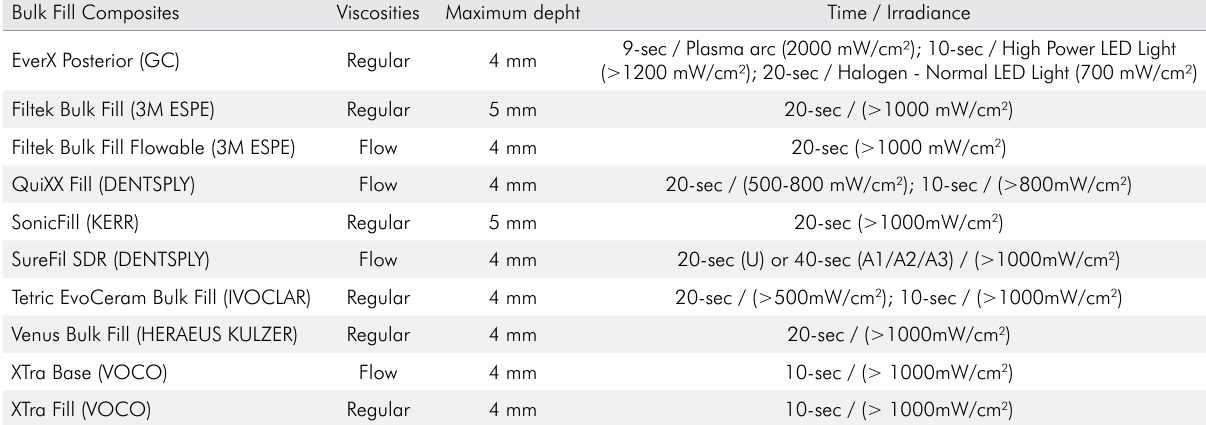
Table 1. Materials under investigation (information as disclosed by the